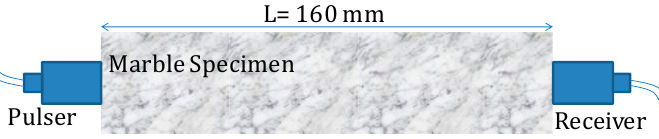
Figure 4. Schematic representation of ultrasound testing.